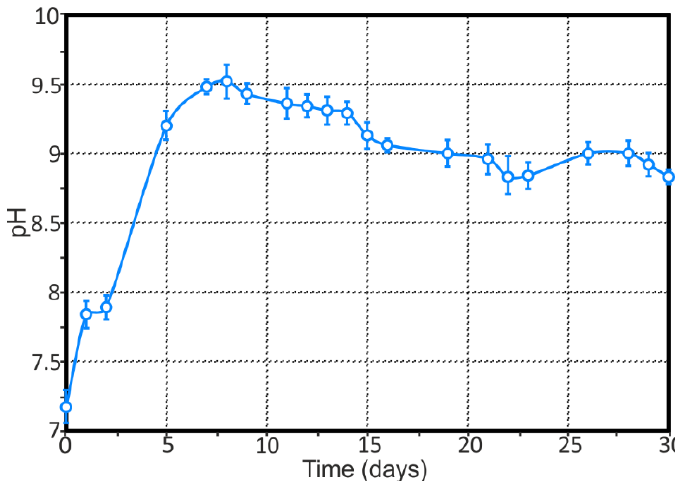
Figure 4. The evolution of bulk pH during 30 days of immersion experiments of the 1579 Al alloy in a 0.5 M NaCl solution. Intensive dissolution of the Mg as an alloying element of the 1579 Al alloy sufficiently shifts the bulk pH values to the alkaline range.